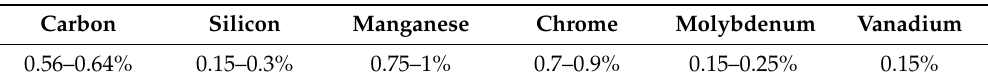
Table 2. Chemical composition of the carbon steel [27].